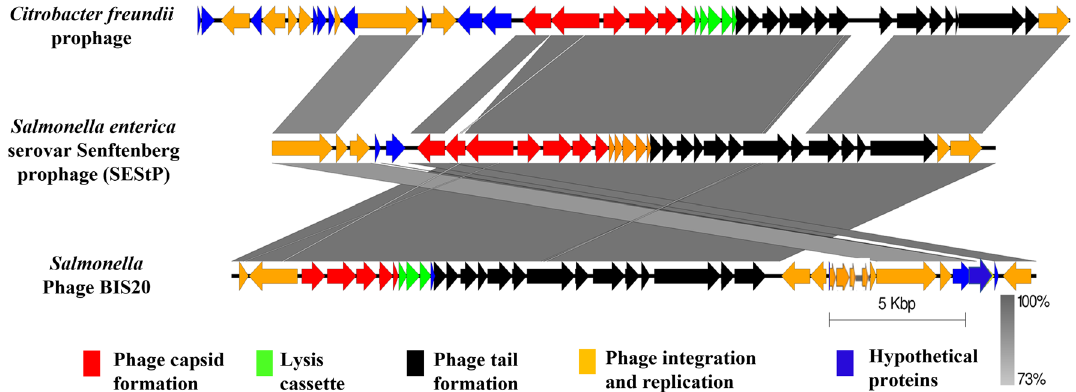
Figure 4. Genome comparison of BIS20 with closest prophage homologs Salmonella enterica serovar Senftenberg prophage (SEStP) and Citrobacter freundii prophage sequence. Various ORFs are color coded according to their putative function. (Scheme provided in Fig. 3).